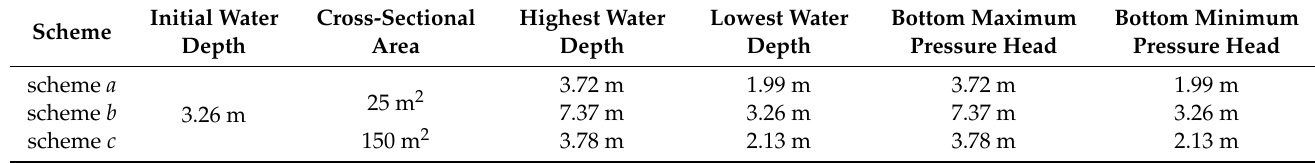
Table 4. Comparison of EDB parameters and bottom pressure head for different